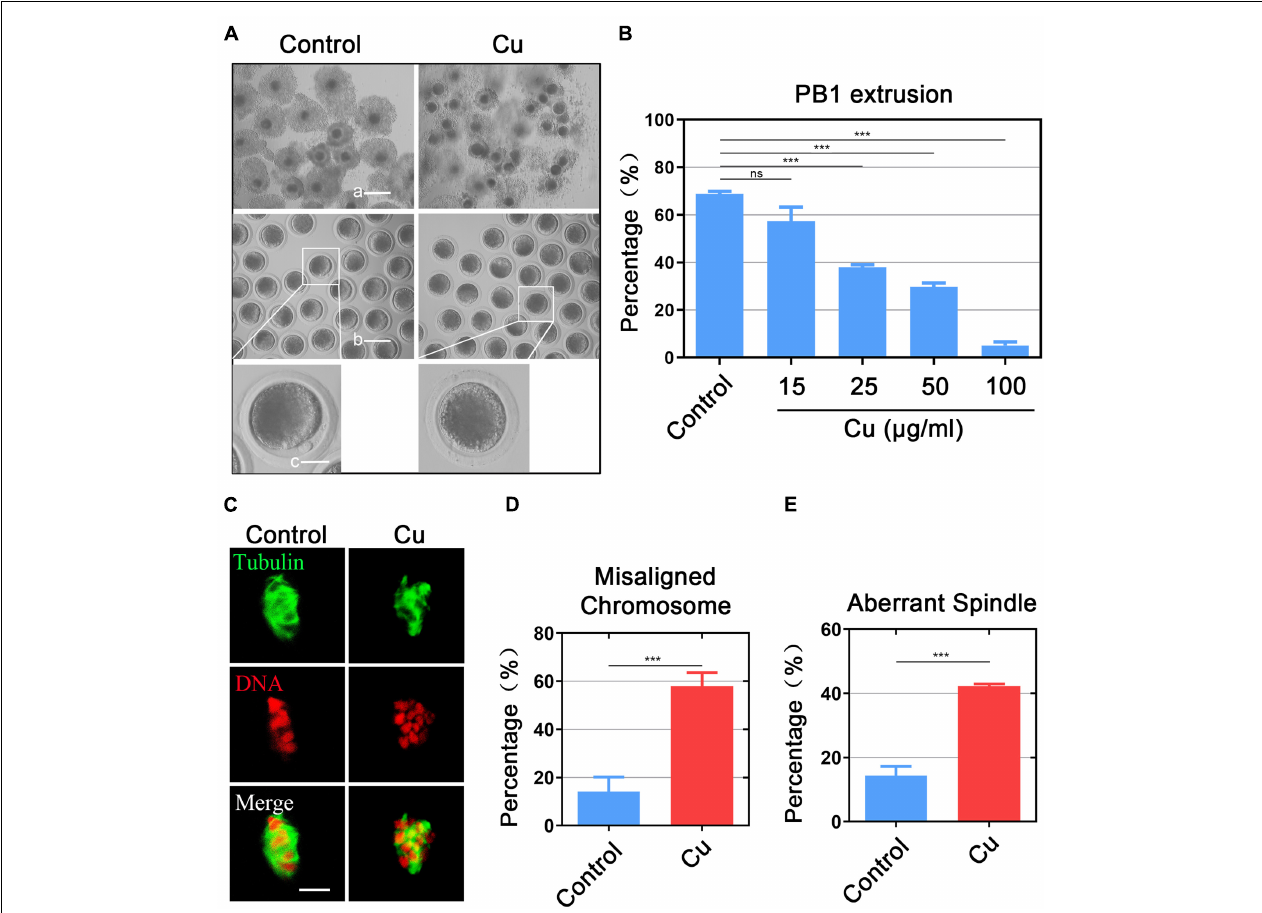
FIGURE 1 | Different doses of Cu perturb the porcine oocyte meiotic maturation and impair the spindle/chromosome structure. (A) Representative images of oocyte meiotic progression in the control and Cu-exposed oocytes. Cumulus cell expansion of COCs and polar body extrusion of DOs (denuded oocytes) were imaged by the confocal microscope. Scale bar, 250 µ m (a); 150 µ m (b); 50 µ m (c). (B) The rate of PBE was recorded in the control group and in different concentrations of the Cu-exposed groups (15, 25, 50, and 100 µ g/mL) after culture for 44 h in vitro . (C) The spindles of oocytes were visualized by immunostaining with anti– α -tubulin-FITC antibody, and the chromosomes were visualized by counterstaining with propidium iodide (PI). Scale bar, 5 mm. (D) The rate of aberrant spindles was recorded in the control and Cu-exposed oocytes. (E) The rate of misaligned chromosomes was recorded in the control and Cu-exposed groups. Data in (B,D,E) were presented as the mean percentage of at least three independent experiments (mean ± SEM). * P < 0.05, ** P < 0.01, *** P < 0.001, ns: no significance.